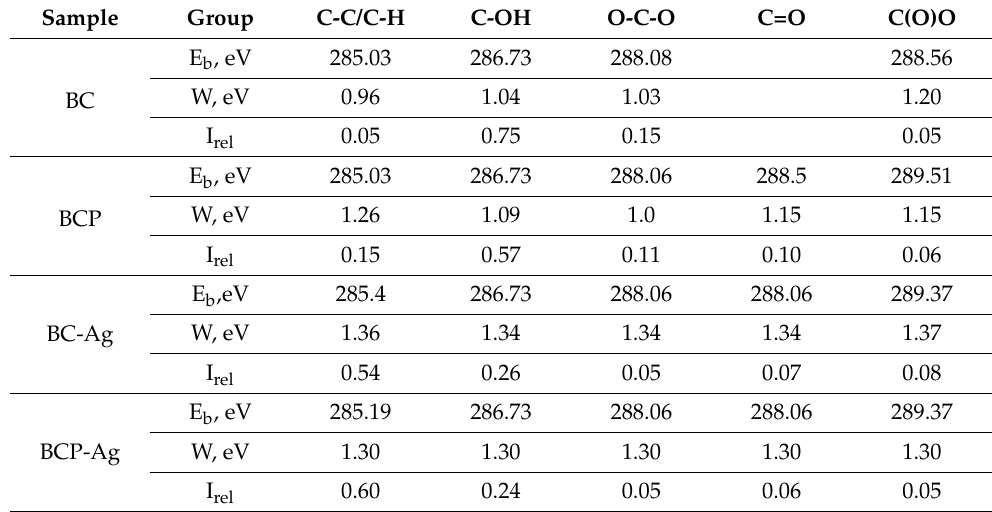
Figure 5. The C 1s spectra for pristine BC ( a ), BCP ( b ), BC-Ag ( c ) and BCP-Ag ( d ), black—experimental, red—fitting, green—individual peaks, blue—peak assigned to C=O group, which ovelapped with peak assigned to O-C-O group. Table 1. Characteristics of the C 1s photoelectron spectra: binding energies (E b ), Gaussian widths (W), and relative intensities (I rel ) of photoelectron peaks belonging to different chemical groups.